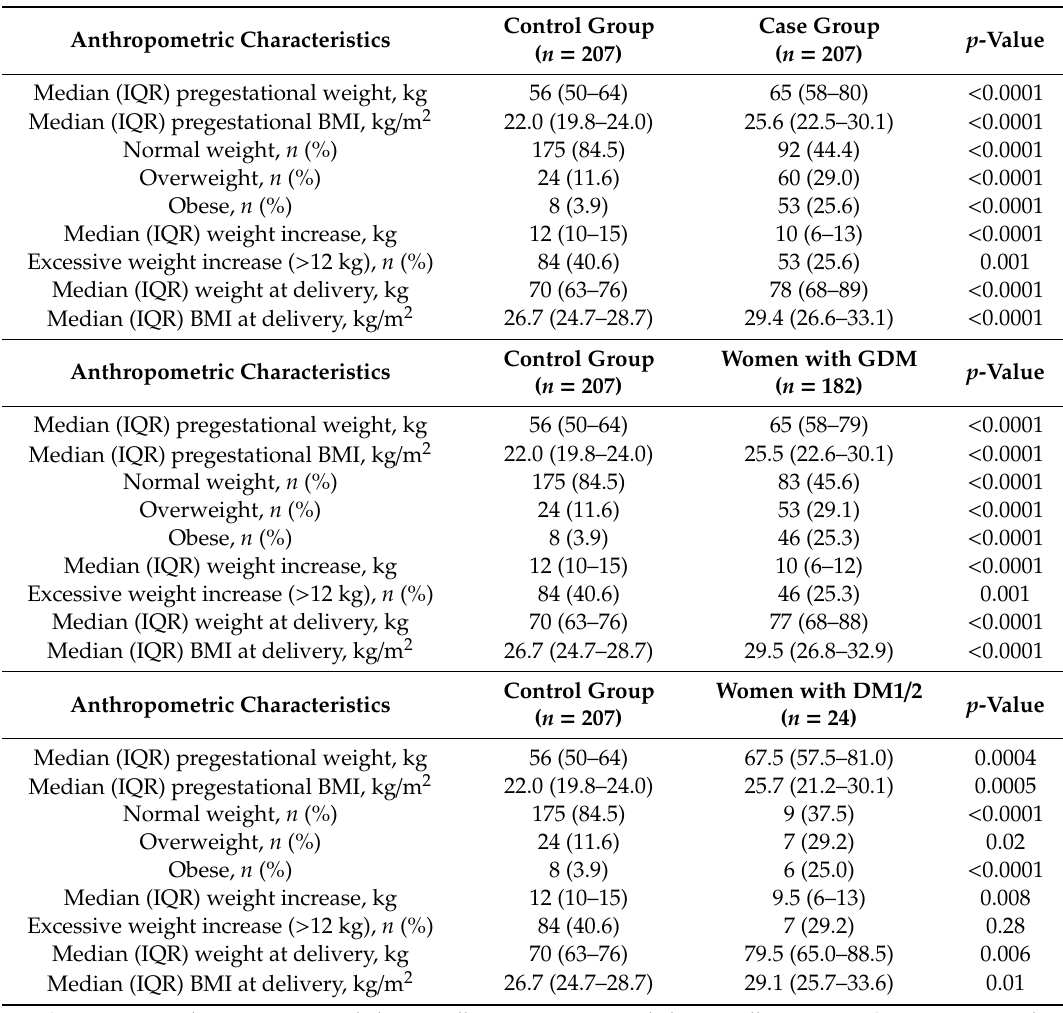
Table 1. Anthropometric characteristics of the